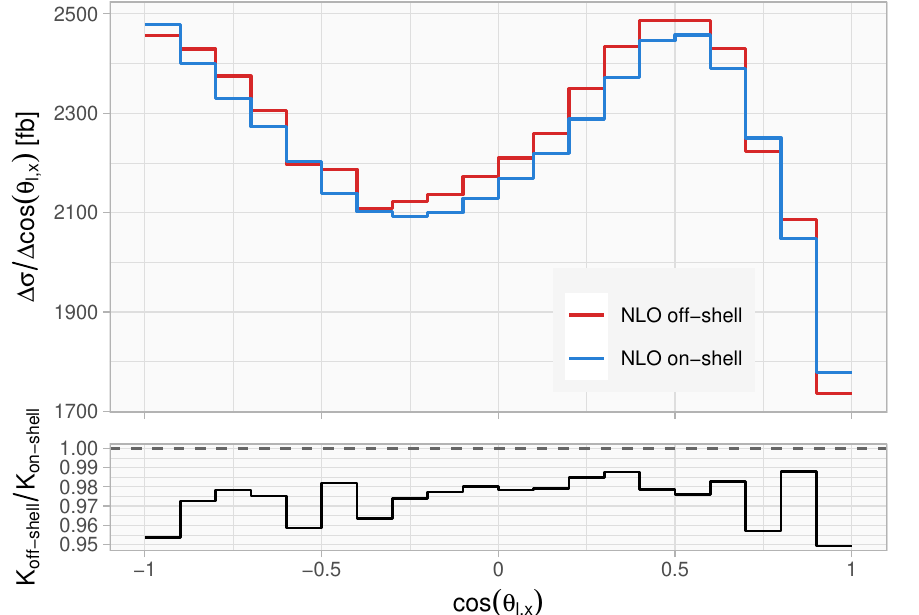
Figure 14. Distribution of cos (cid:18) l;x at NLO in the on-shell approximation and for an o(cid:11)-shell top quark. The lower panel shows the ratio of the o(cid:11)-shell and on-shell K -factors. Note the range of the y -axis, which does not start at zero.